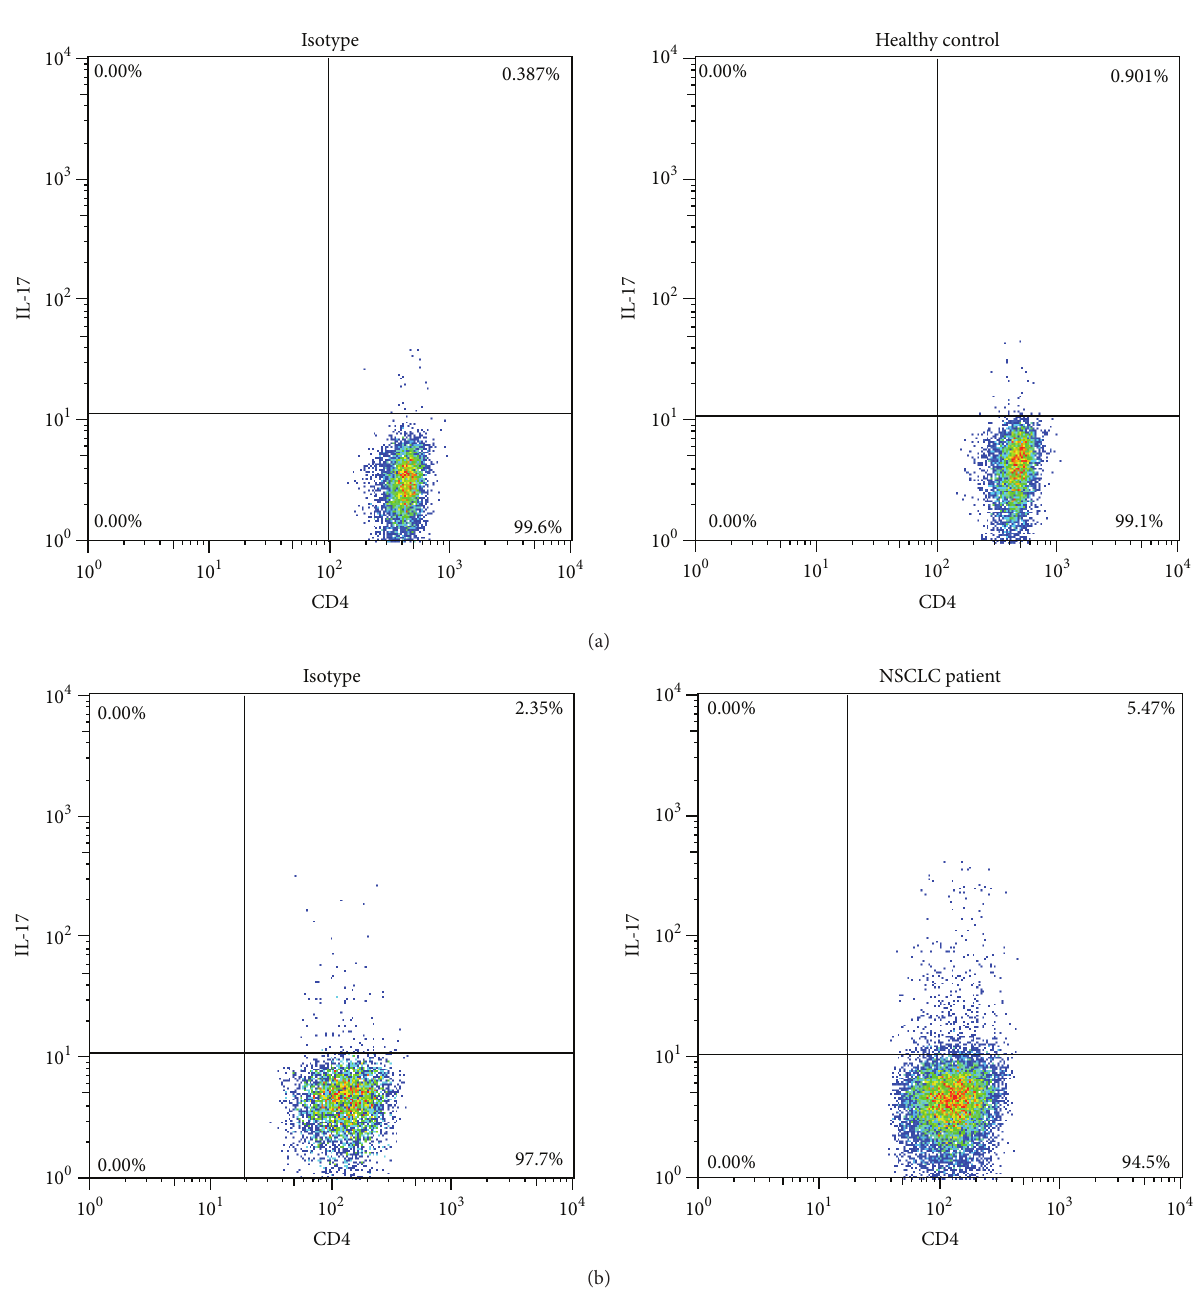
Figure 3: The frequency of CD4+IL-17+ (Th17) cells in peripheral blood was measured by flow cytometry. (a) Representative FACS staining for IL-17A in gated CD4+ T cells from a single patient in healthy controls. (b) Representative FACS staining for IL-17A in gated CD4+ T cells from a single patient in NSCLC